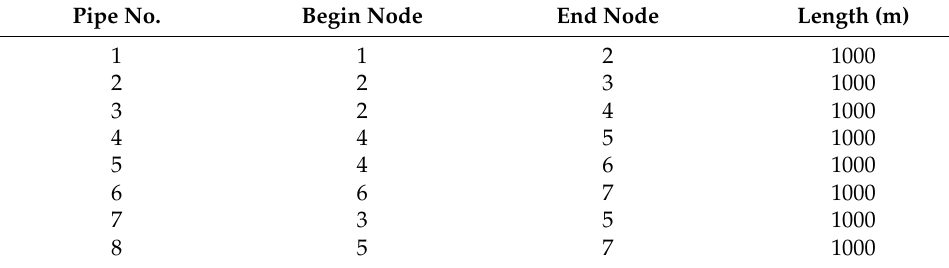
Table A2. Pipe data for the Two-loop